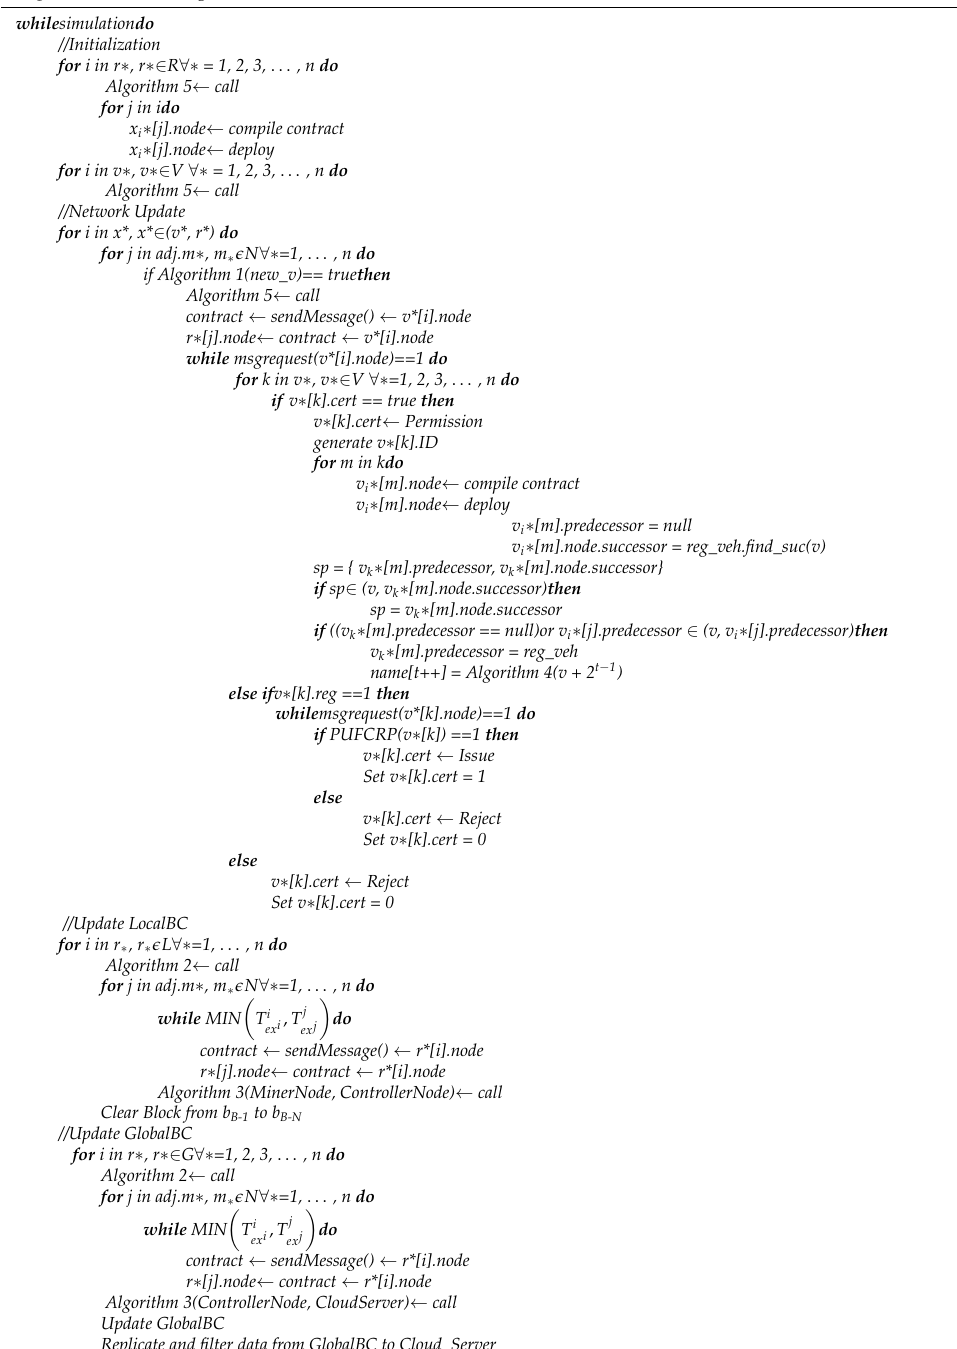
Algorithm 6: Simulating the